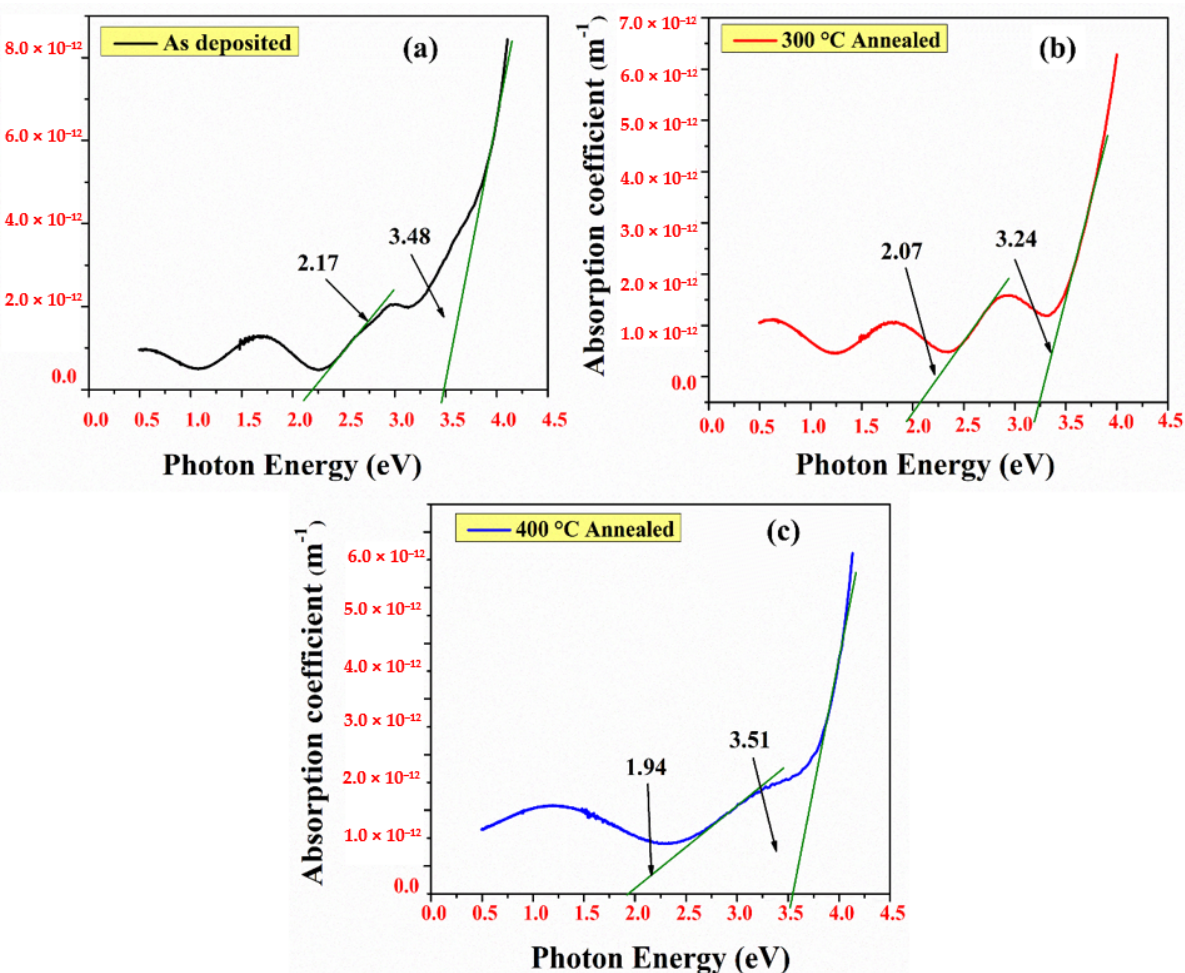
Figure 3. The plot of optical absorption coefficient ( α ) vs. photon energy (h ν ) of multi-layered HfO 2 /V 2 O 5 /HfO 2 thin films: ( a ) as-deposited; ( b ) annealed at 300 ◦ C; and ( c ) annealed at 400 ◦